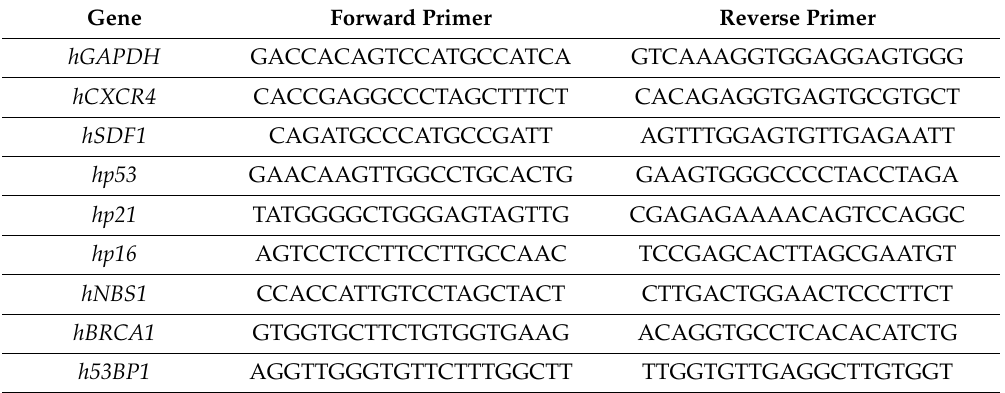
Table 1. Primers for real-time PCR